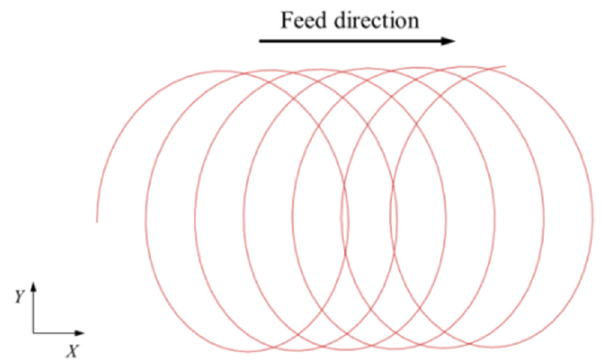
Figure 2. Extended cycloidal path for the laser quenching process [26].